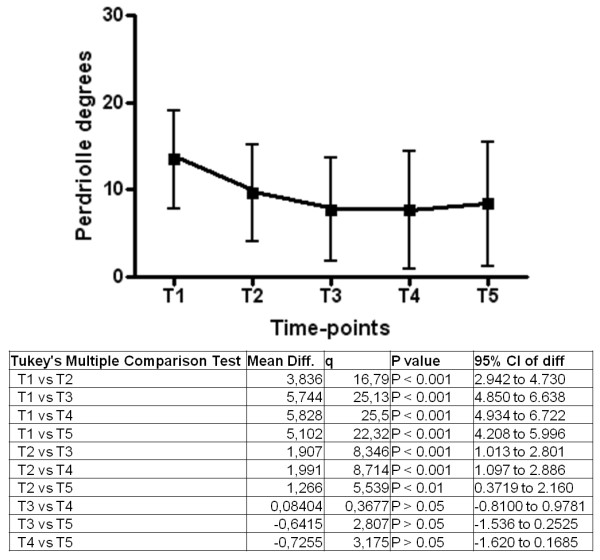
Changes in TA over time in the whole study sample (n = 113).